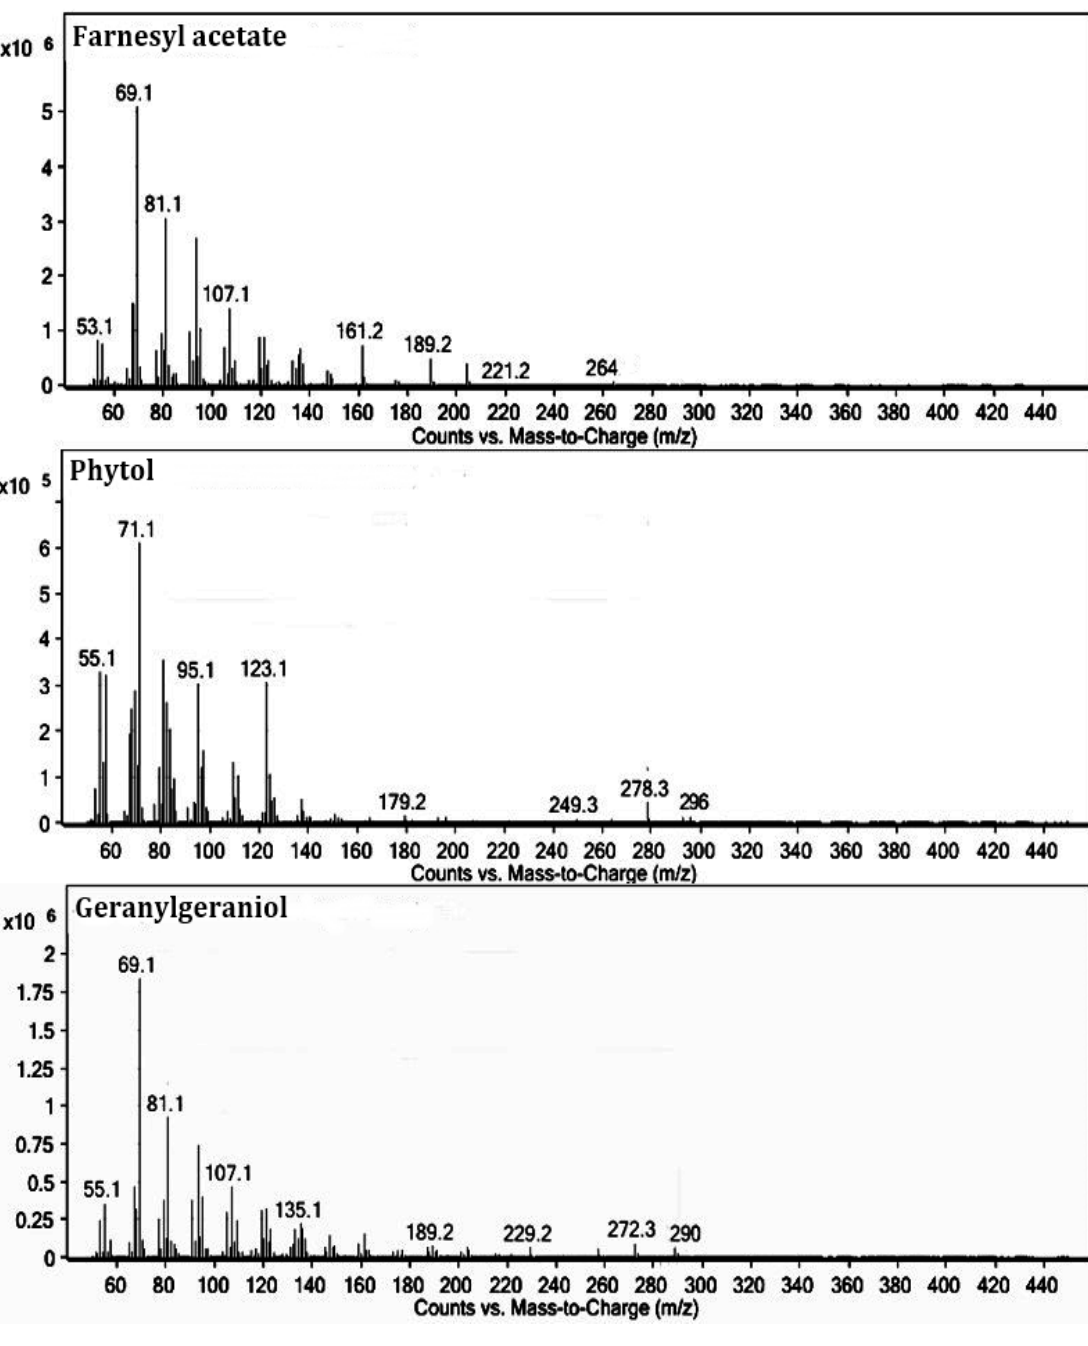
Figure 3. Mass spectrum of farnesyl acetate (P10), phytol (P7), and geranylgeraniol (P6).